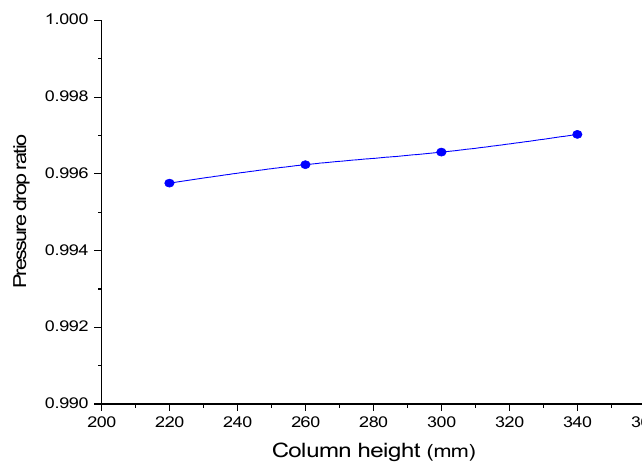
Figure 12. Effect of column height on the pressure drop ratio.